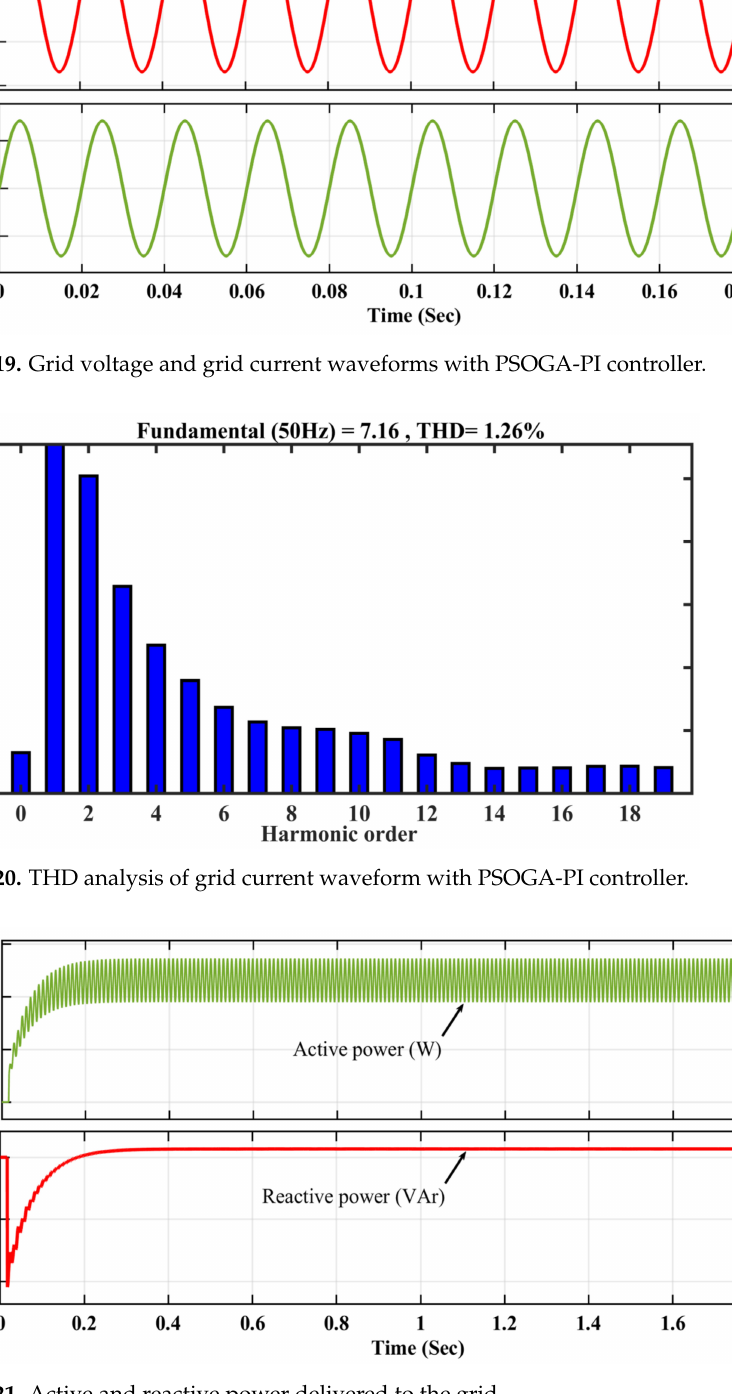
Figure 21. Active and reactive power delivered to the